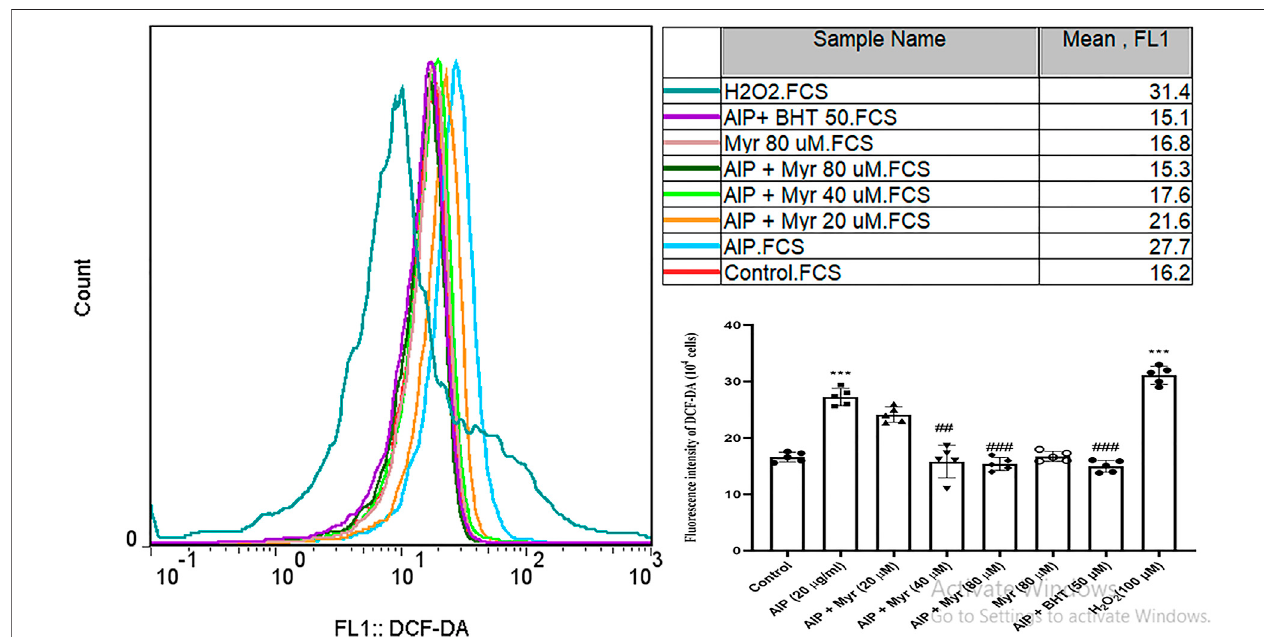
FIGURE 2 | Myr inhibits AlP-induced ROS production in isolated cardiomyocytes. As shown, the fl uorescence intensity of DCF is increased after exposure to AlP. The peak is moved to theright as compared withcontrol, while cotreatmentof Myr(40 and 80 µM)with AlP showed thatthe fl uorescence intensity ofDCF isdecreased, and the peaks are moved to the left. Values represent mean ± SD ( n (cid:2) 3) of three independent experiments, *** p < 0.001 compared with control; ## p < 0.01; ### p < 0.001comparedwithAlP-treatedcardiomyocytes,one-wayANOVA, Tukey ’ stest. Myr,myricetin; AlP,aluminum phosphide; ROS,reactiveoxygenspecies;DCF- DA, 2 ʹ ,7 ʹ -dichloro fl uorescin diacetate; BHT, butylated hydroxytoluene; H 2 O 2 , hydrogen